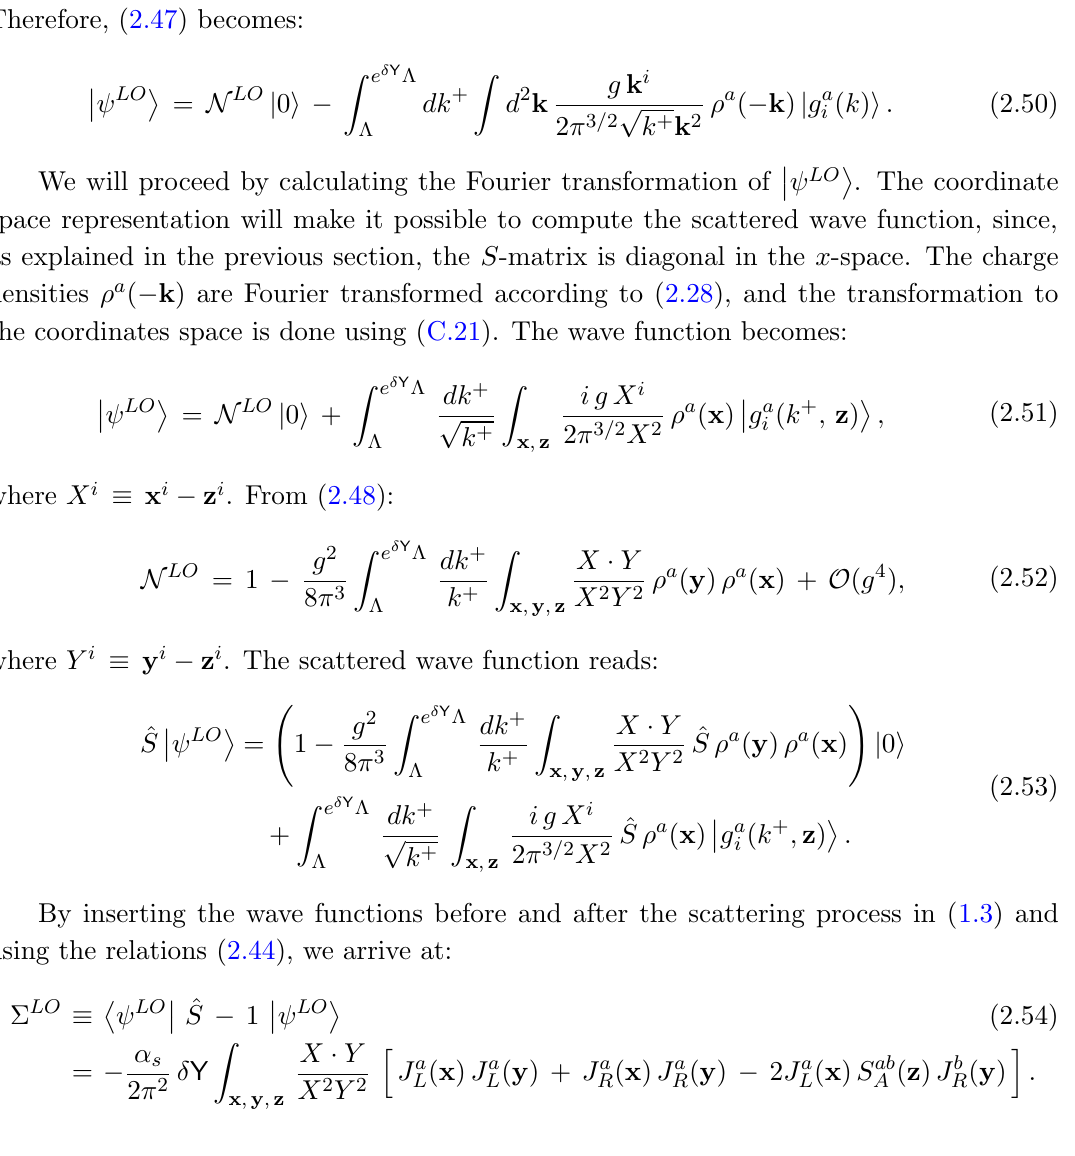
( k ) i that contributes to (2.47). The only non- i , g